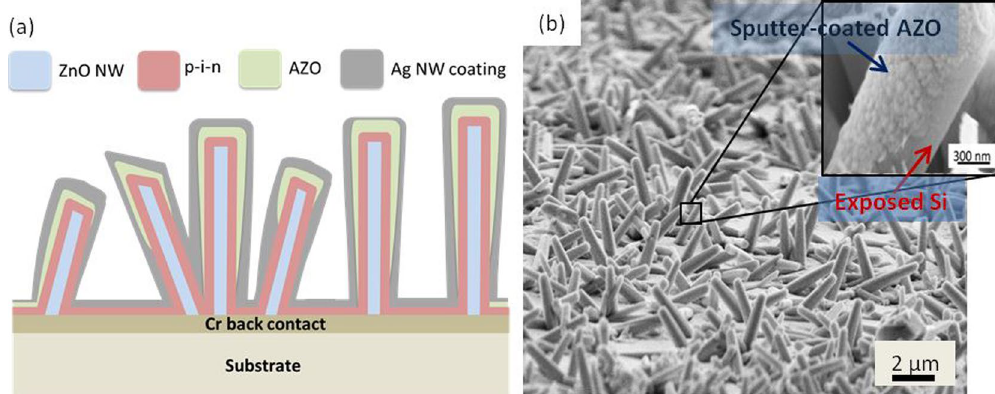
Figure 1. ( a ) Schematic diagram of the 3-D NWSCs with 40 nm p + , 300 nm i, and 40 nm n + a-Si:H coated